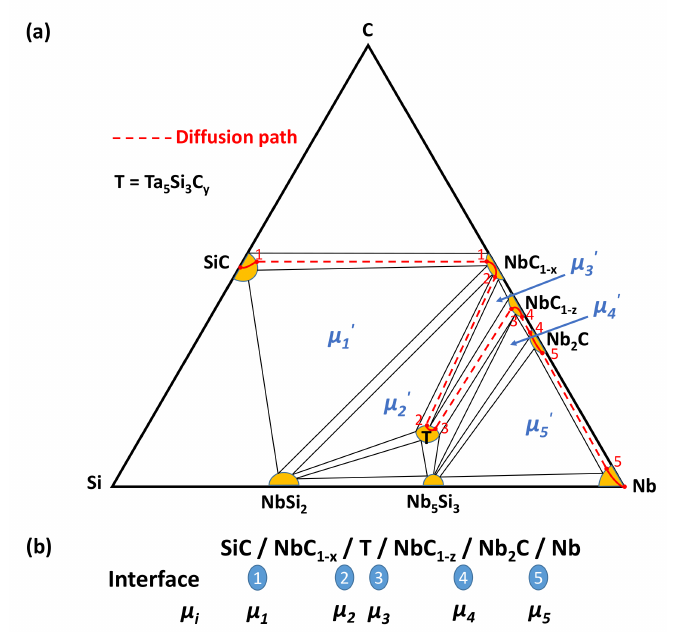
Figure 20. Schematic isothermal section of the ternary Nb–Si–C system. ( a ) Diffusion path between 1200 and 1500 ◦ C. ( b ) Chemical potentials at the different